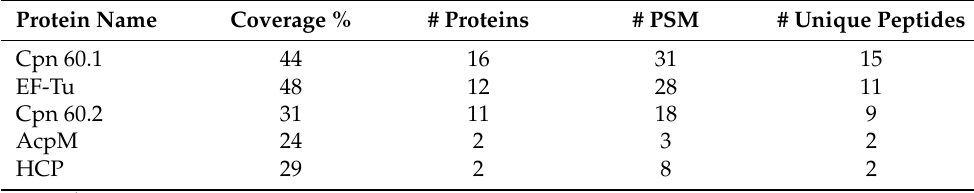
Table 1. Identified interacting proteins from Co-IP and LC–MS/MS